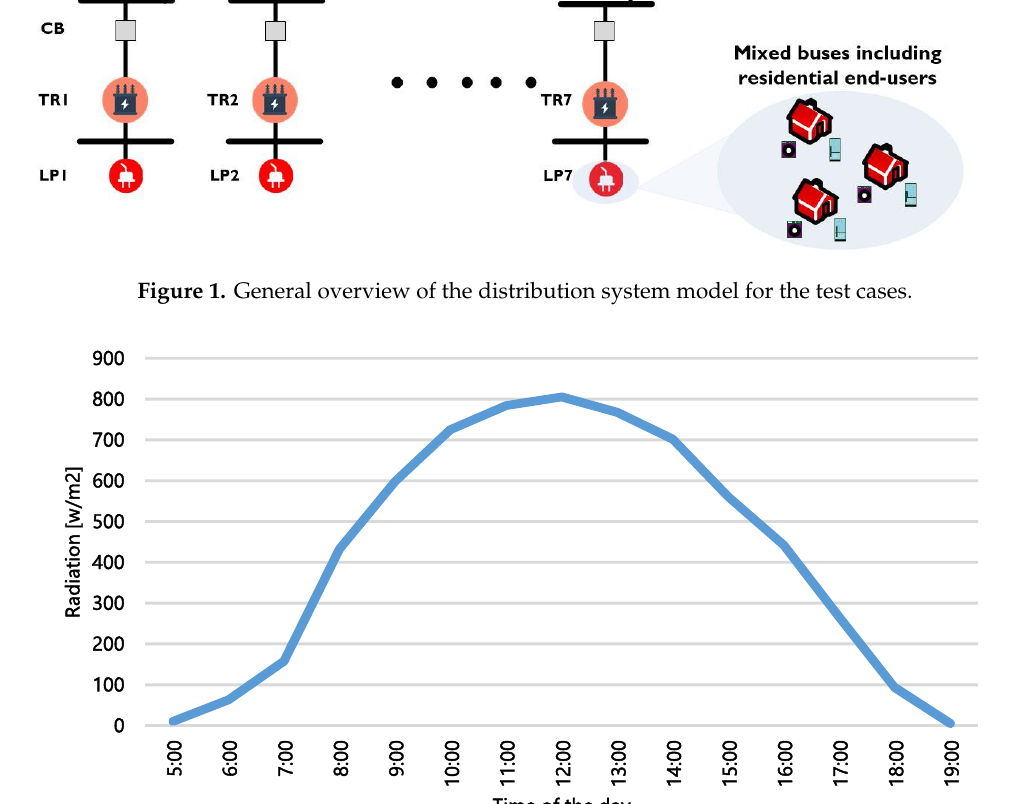
Figure 2. The used radiation data taken from National Renewable Energy Laboratory (NREL).